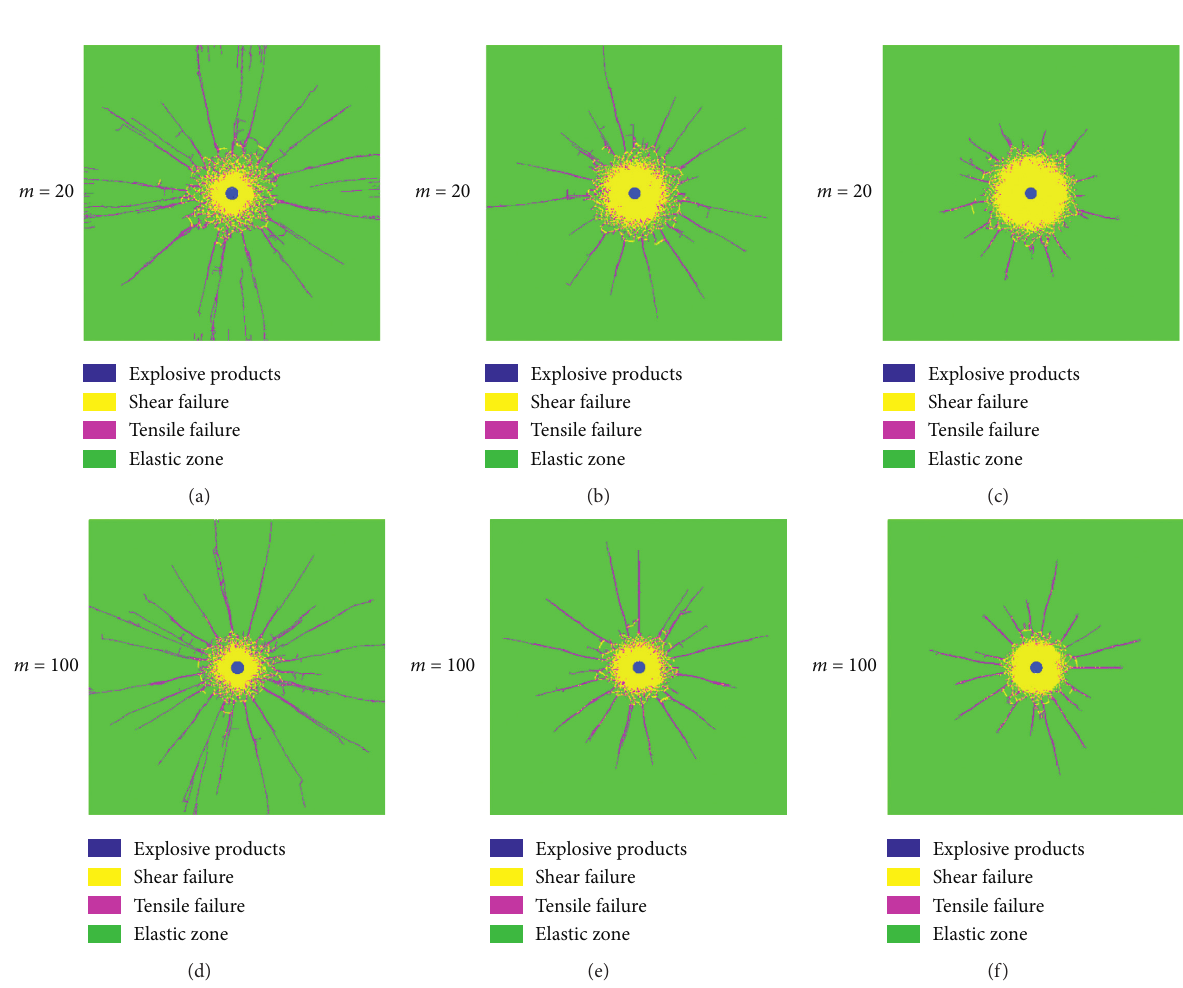
� 5MPa. y when P x